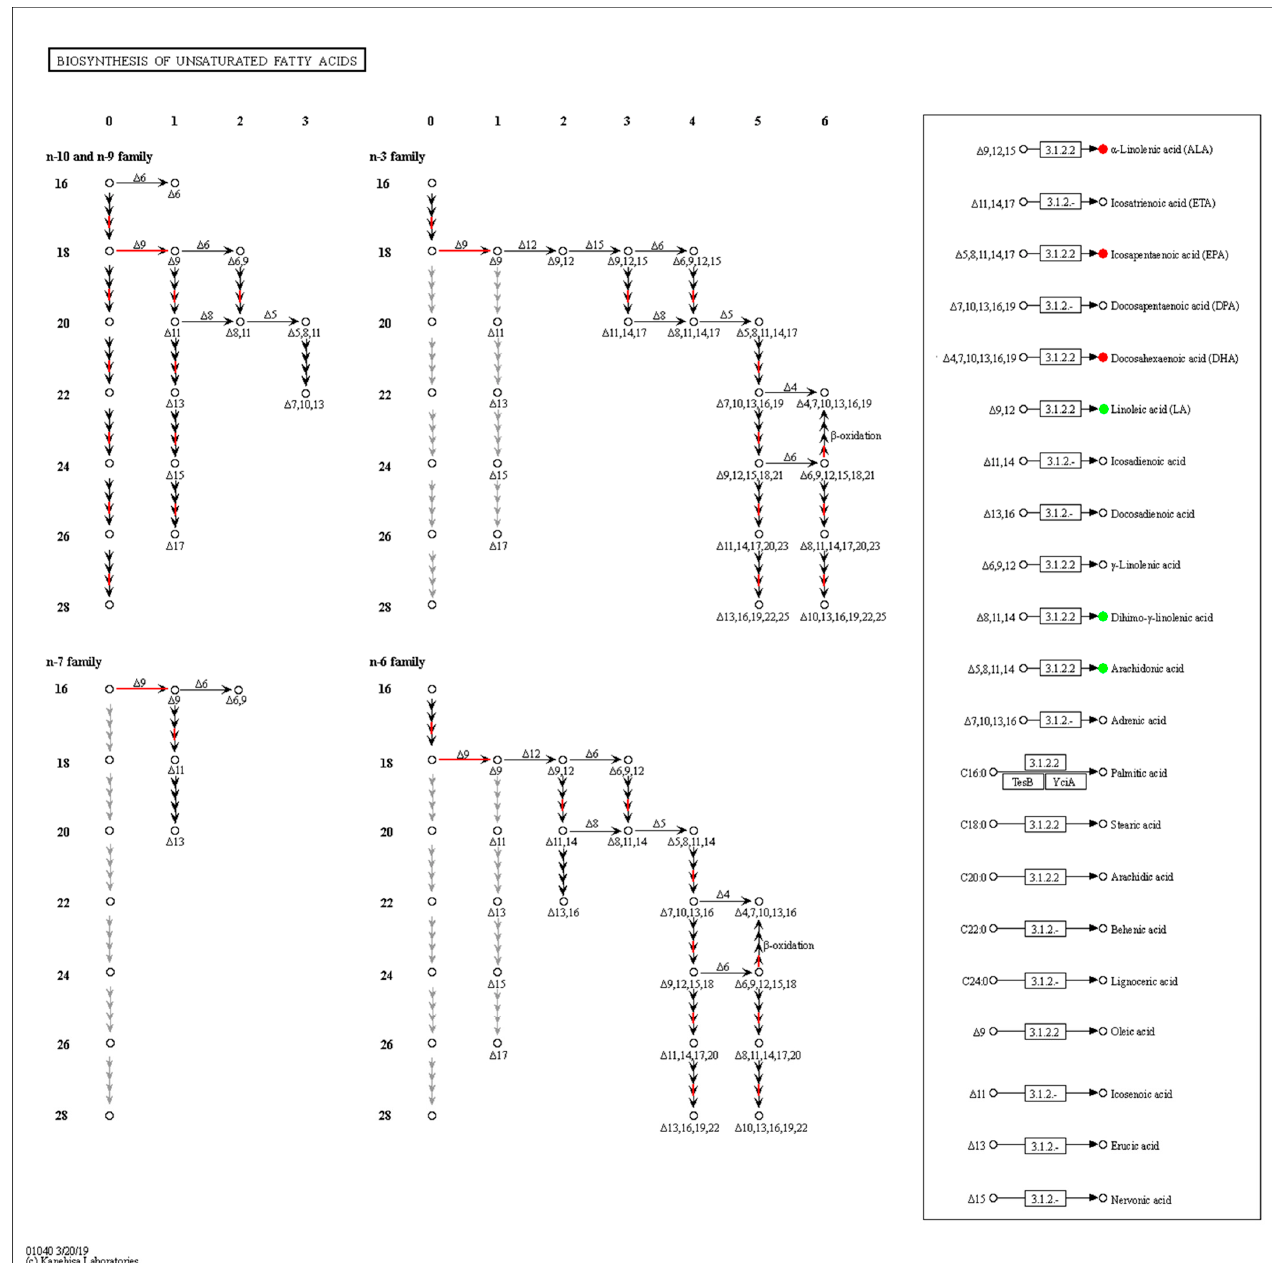
Figure 6. Enrichment of differentially expressed genes and differentially oxidized lipid metabolites in the biosynthesis of the unsaturated fatty acids pathway. DEGs are shown on the left side, the abscissa is the number of double bonds, the ordinate indicates the number of carbon atoms in the skeleton, and the red arrow indicates the upregulation of gene expression. The box on the right shows the differential metabolism of the main PUFAs, with red circles indicating upward metabolites and green circles indicating downward metabolites.